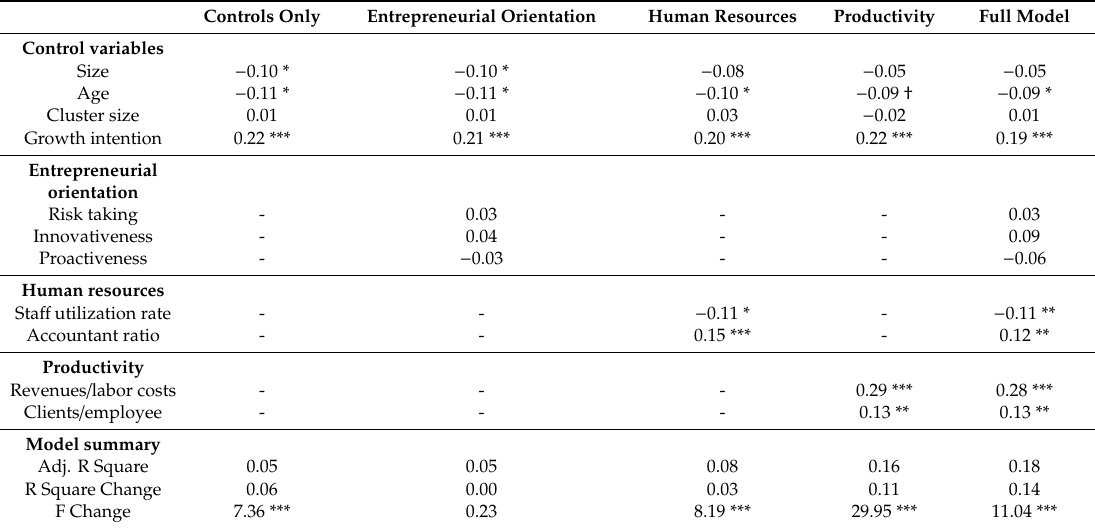
Table 2. Prediction of sales growth from 2011 to 2015 (n = 452).